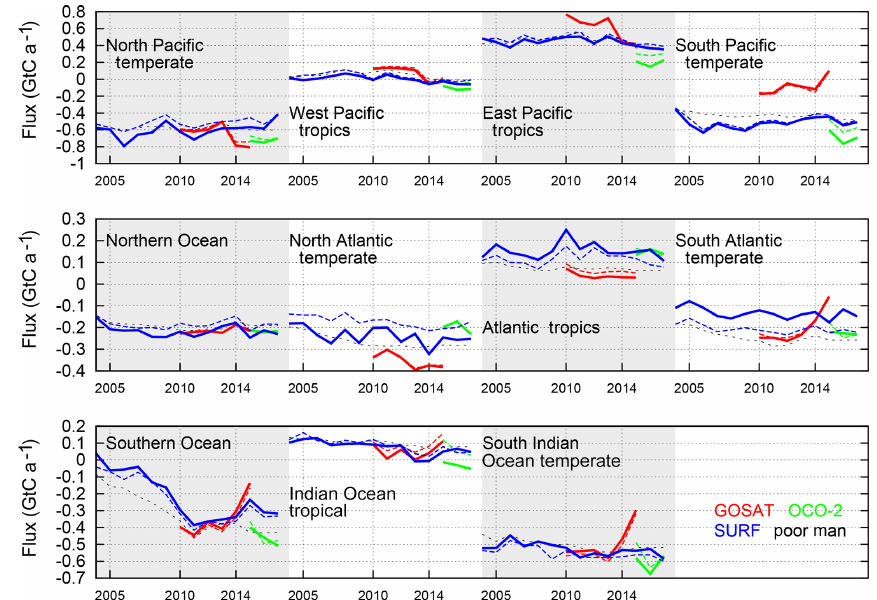
Figure 4. Same as Fig. 3 but for oceanic regions. Note that the prior fluxes over the ocean are equal to the “poor man” curve (see Sect.